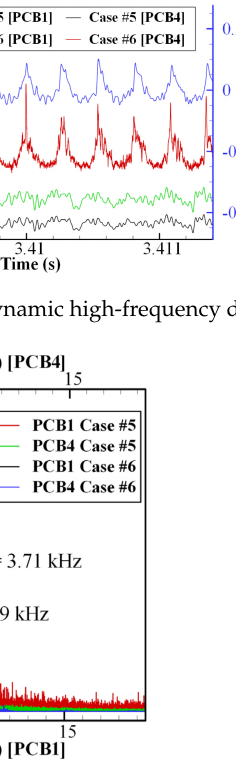
Figure 16. FFT distribution of Case #5 and #6 in the isolator and